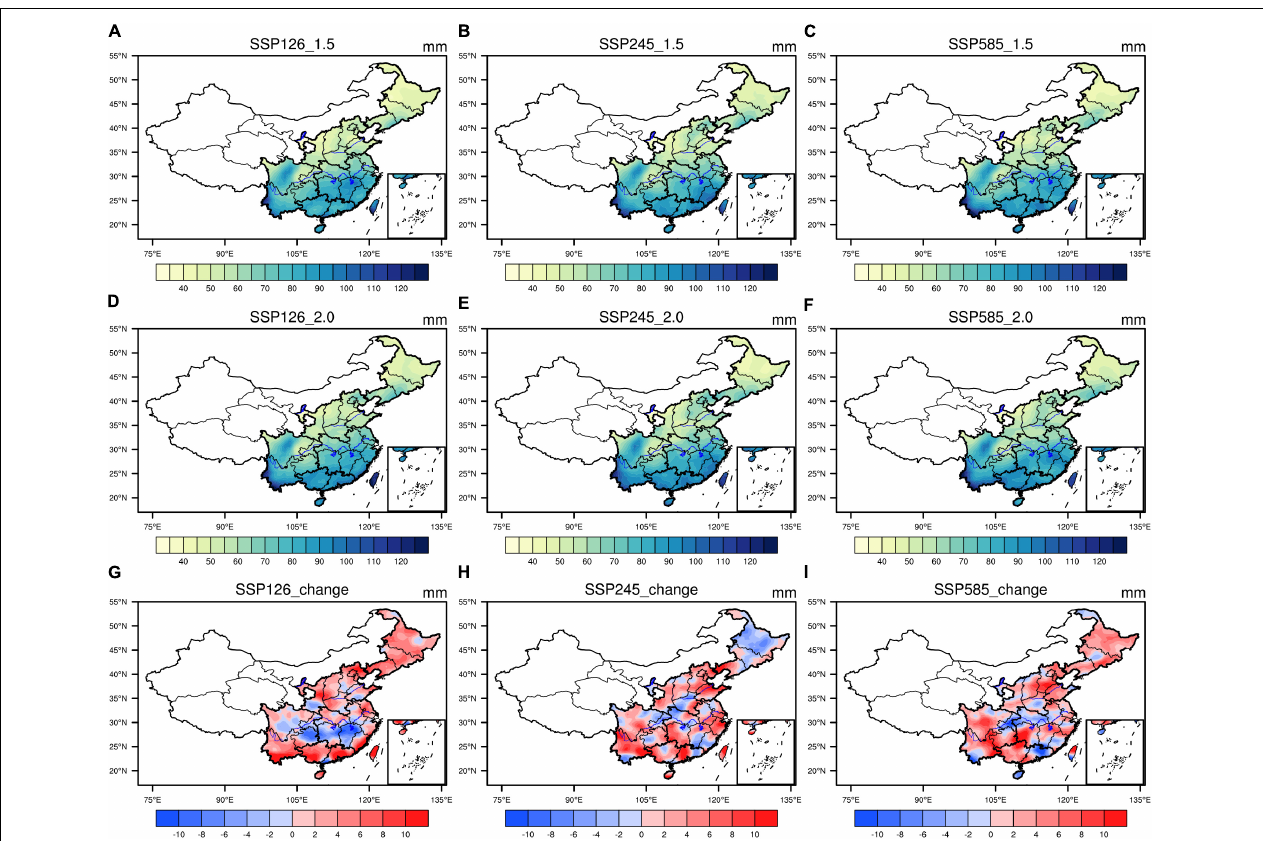
FIGURE 7 | Distribution of 5-day maximum precipitation (Rx5day) at 1.5 and 2 ◦ C. (A–C) Global warming at 1.5 ◦ C under SSP126, SSP245, and SSP585, respectively. (D–F) Global warming at 2 ◦ C under SSP126, SSP245, and SSP585, respectively. (G–I) The differences between global warming at 1.5 and 2 ◦ C.